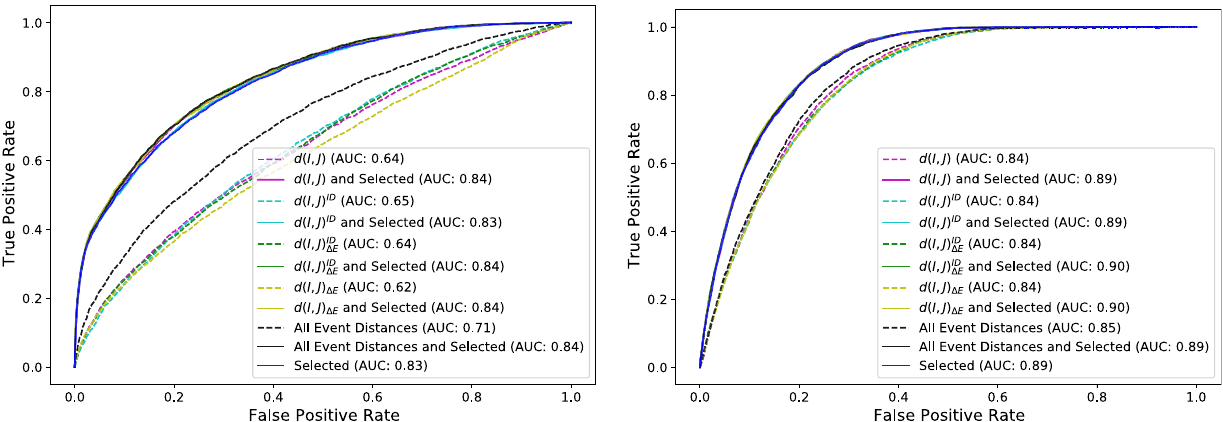
only retain more confident predictions. In these